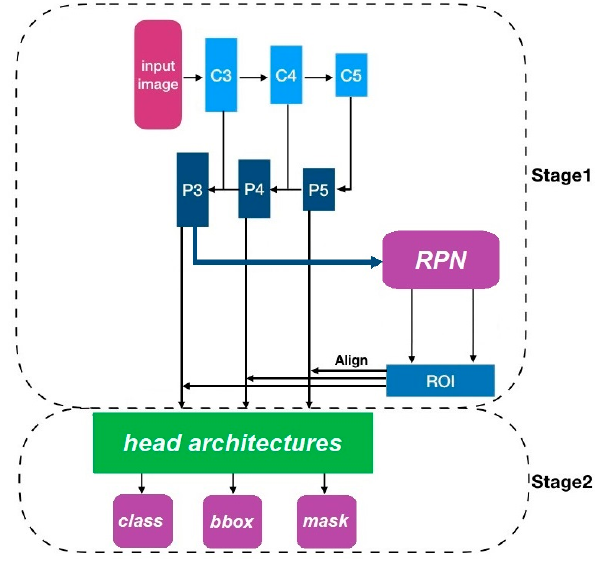
Figure 3. Schematic of Mask R-convolutional neural network (CNN) method. The features computed from the C3 ... C5, P3 ... P5 pyramid structure are fed into the Region Proposal Network (RPN) and also into the Mask R-CNN classification step. ROI: region of interests.